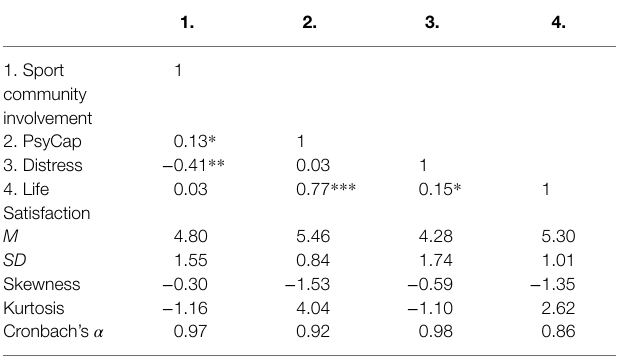
TABLE 1 | Descriptive statistics and correlations for study variables ( N =